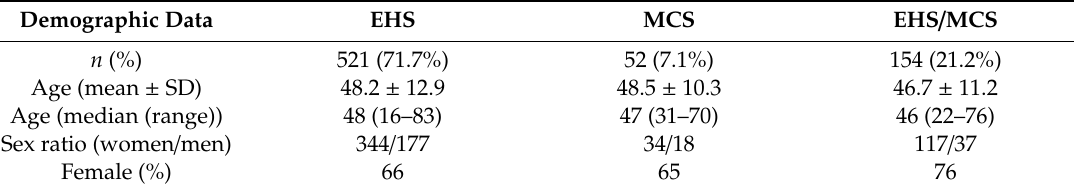
Table 2. Age and sex ratio in EHS and / or MCS self-reported patients, according to Reference [10]. Demographic